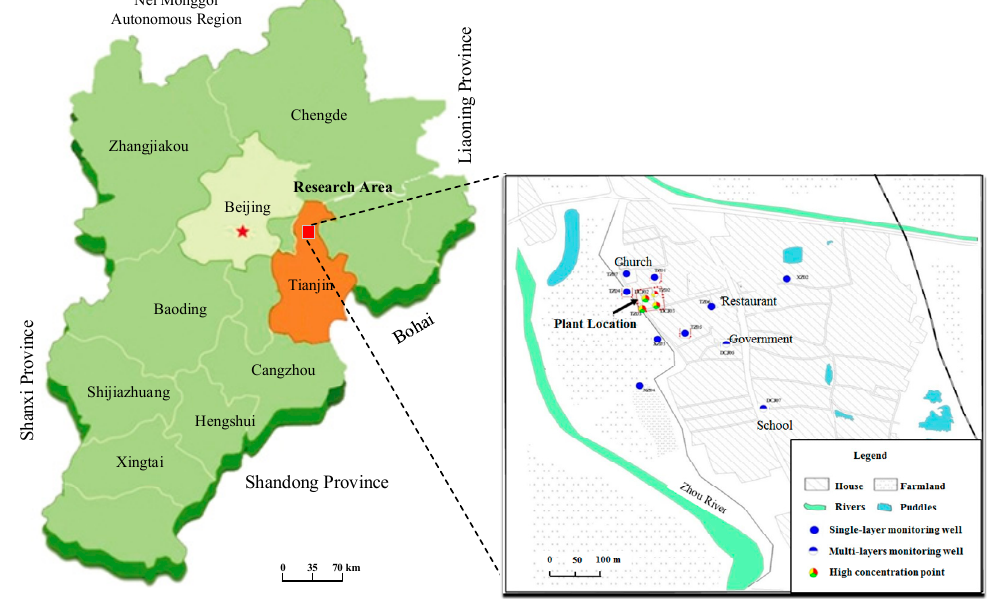
Figure 1. Location and pollution survey points of the site.